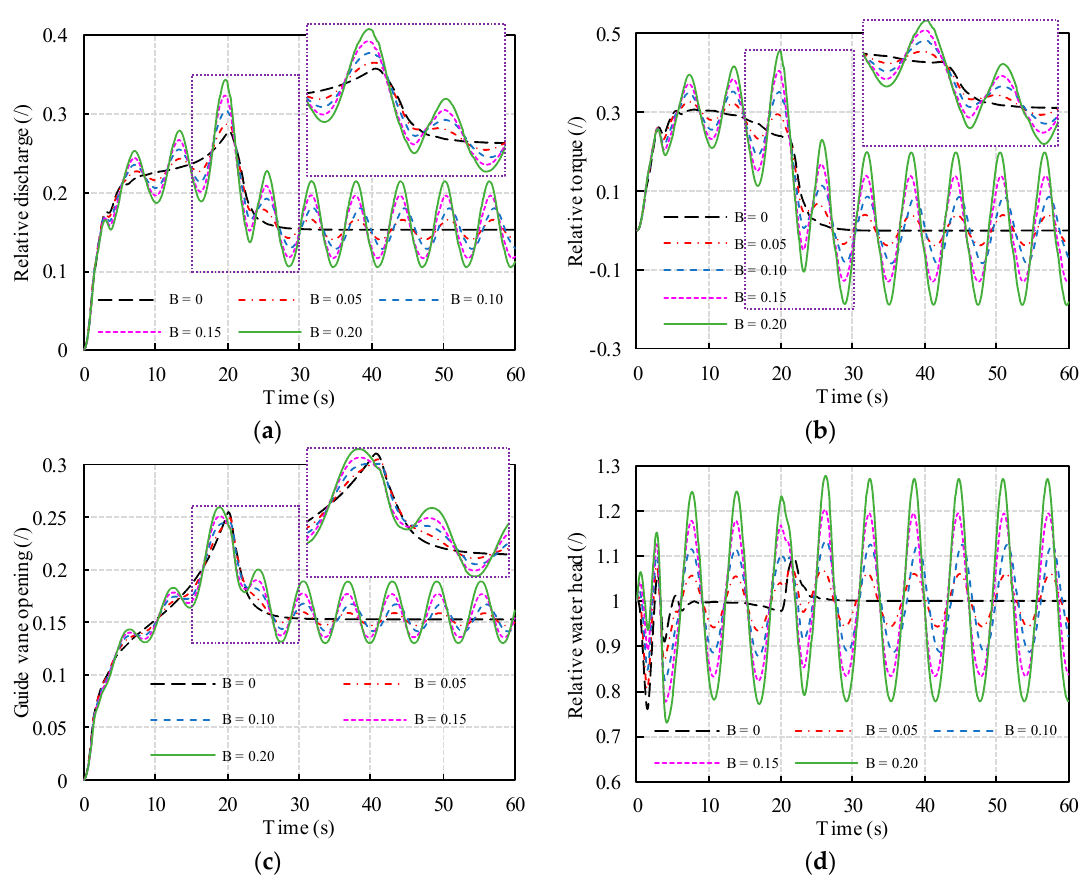
Figure 8. Comparison of closed-loop start-up characteristics of different tail water fluctuation amplitudes under a fixed frequency: ( a ) Time history of discharge; ( b ) time history of torque; ( c ) time history of guide vane opening; and ( d ) time history of water head.